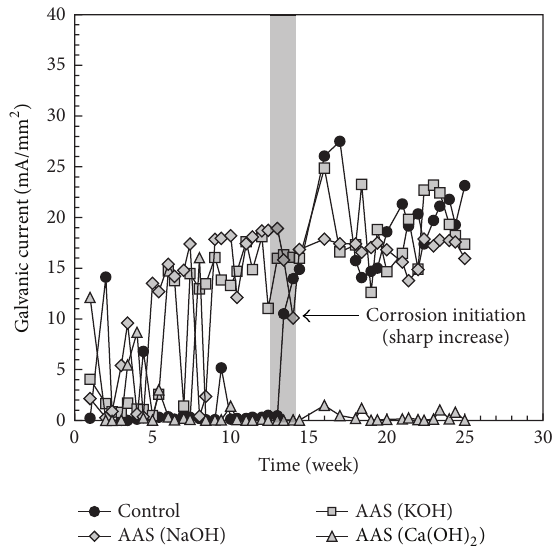
Figure 7: Monitoring of galvanic currents of steel in AAS mortar.